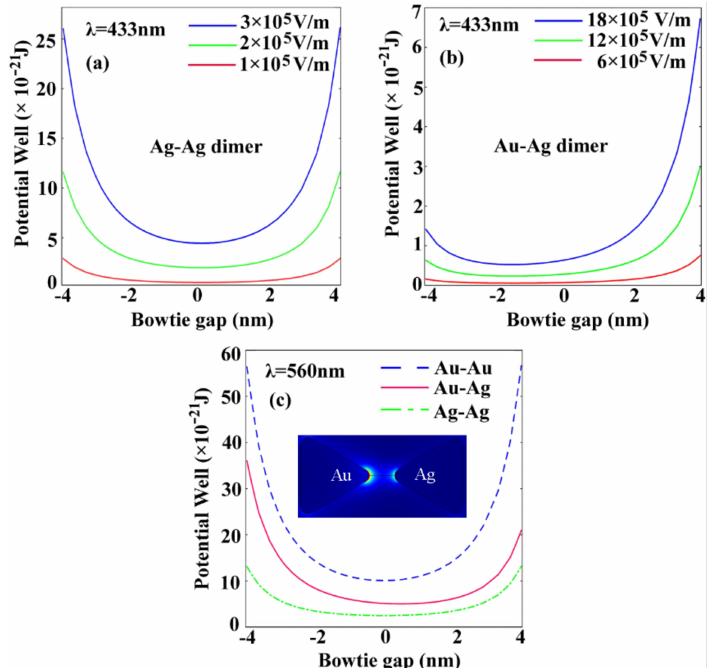
Figure 3. The plasmonic trapping potential distribution along the bowtie gap with respect to homogenous ( a ) and heterogeneous bowtie geometries ( b ) for different laser fields and different materials ( c ). The bowtie edge length is 20 nm, the bowtie gap is taken as 10